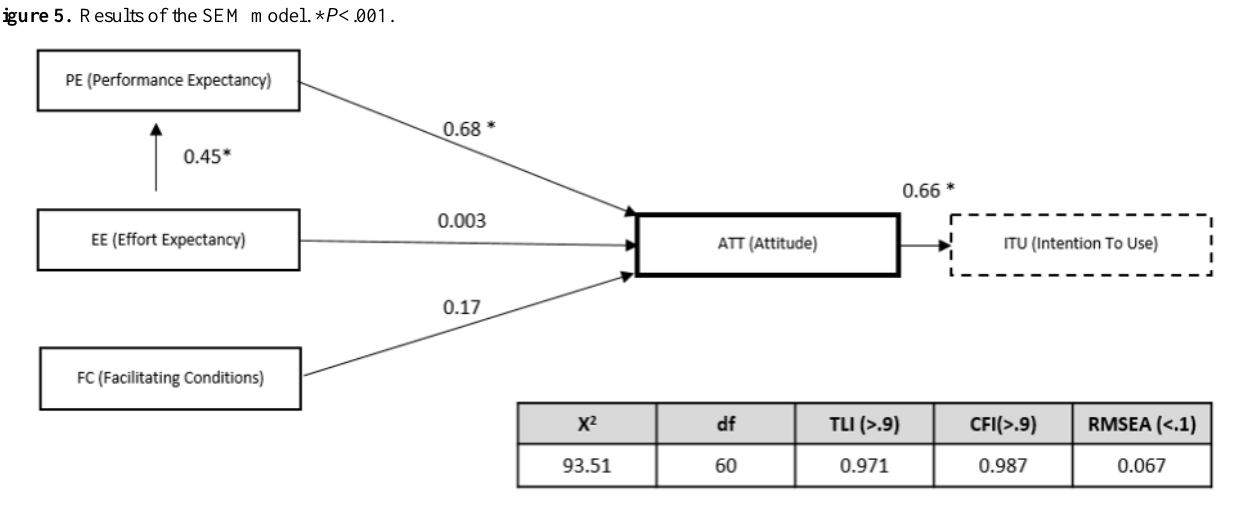
Figure 5. Results of the SEM model. * P